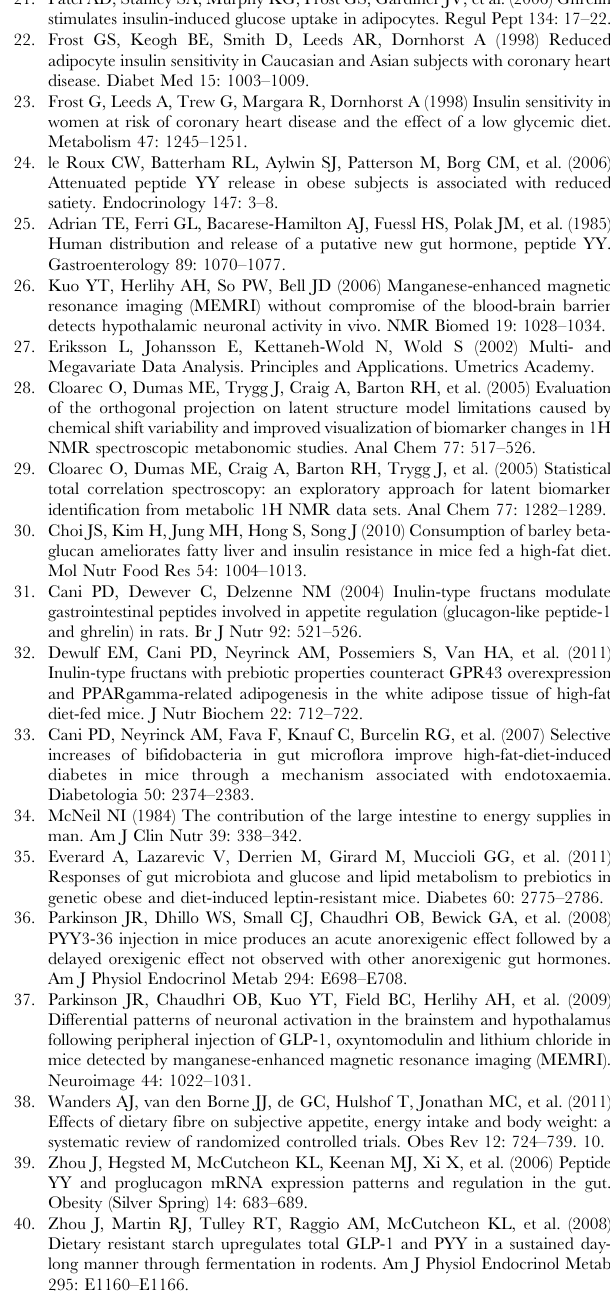
Table S1 Composition of diets. Table S2 Pair wise OPLS-DA models assessed by Q 2 Yhat and the significance of model based on 500 times random permutation of Y matrix. Figure S1 Median fecal 1 H NMR spectra of mice (a)